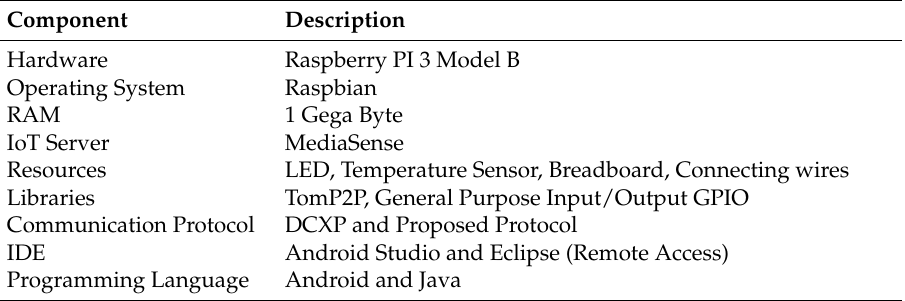
Table 2. Technology Stack of IoT